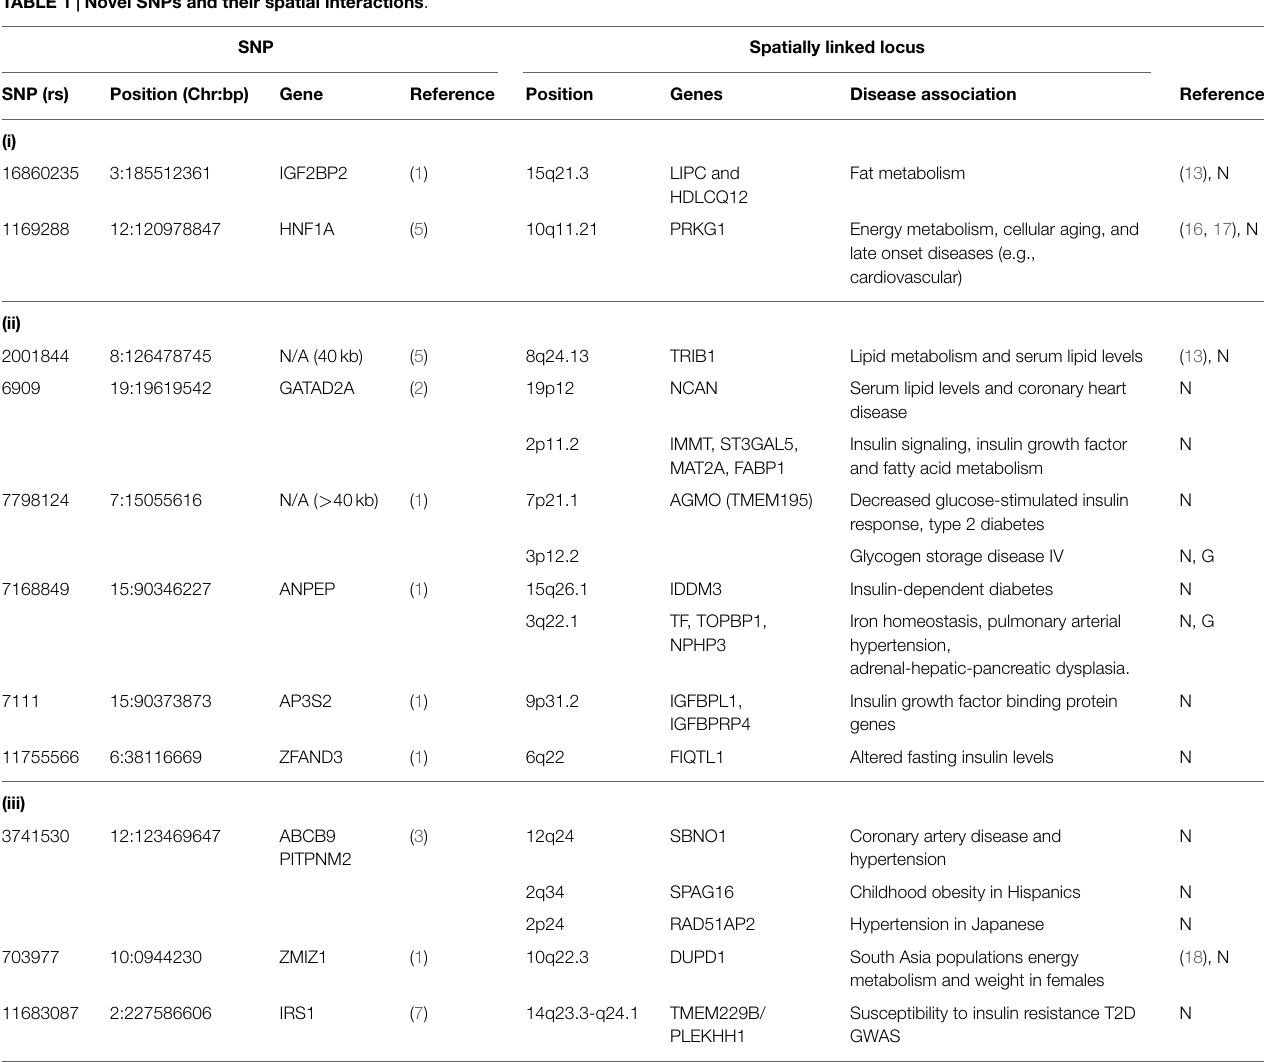
TABLE 1 | Novel SNPs and their spatial interactions .